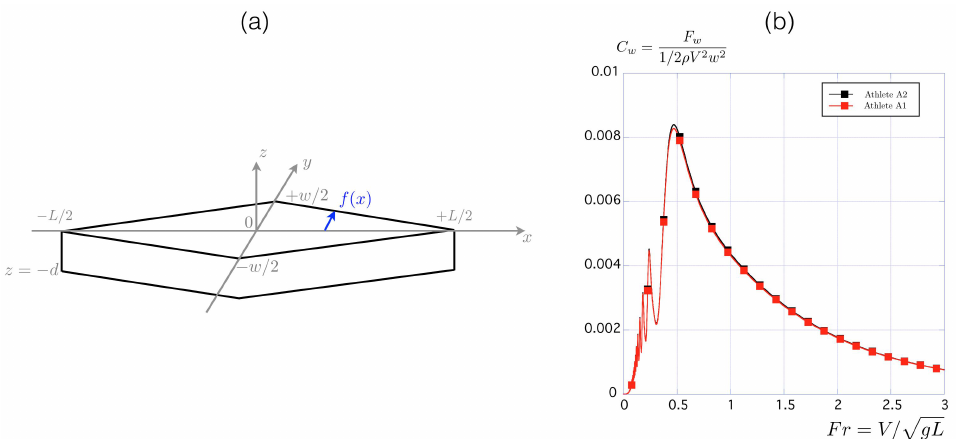
Figure A1. ( a ) Scheme of a prismatic hull. ( b ) Evolution of the wave drag coefficient C w with the Froude number calculated with Equation